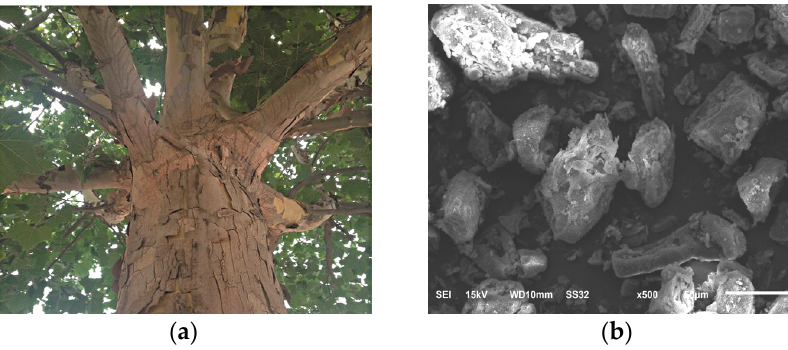
Figure 1. The photograph of the barks on the plane tree and the SEM micrograph of the bark flours. ( a ) barks; ( b ) bark flours.